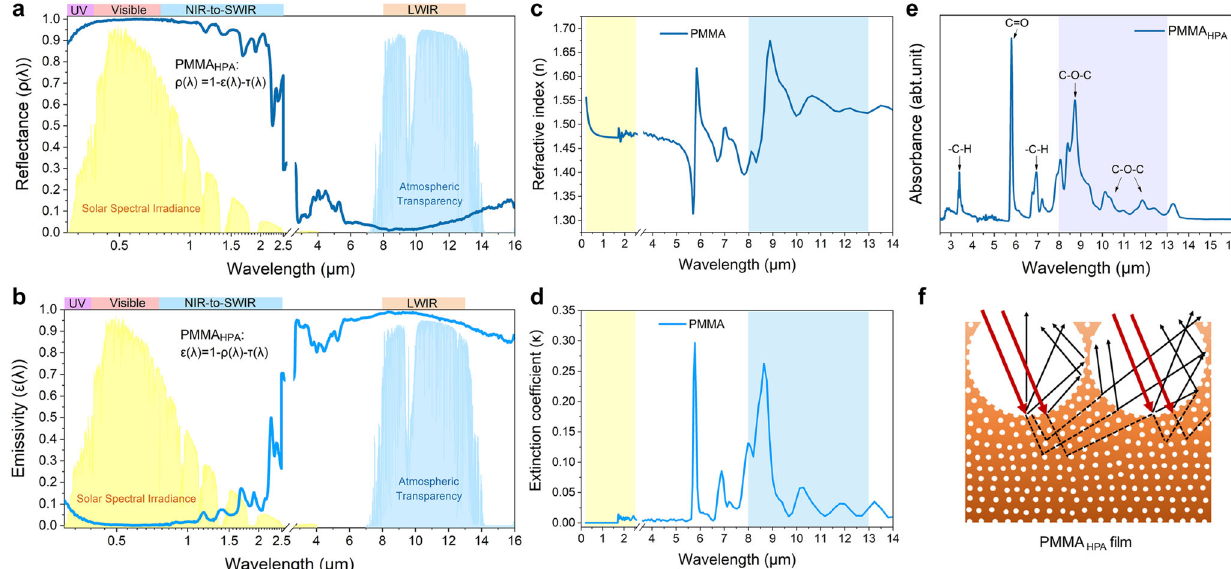
Fig. 2 Spectroscopic response of the PMMA HPA fi lm. a , b Spectral re fl ectance and emissivity of the PMMA HPA fi lm with ~160 μ m effective thickness along with the normalized ASTM G173 Global solar spectrum and the LWIR atmospheric transparency window. c , d Spectral refractive index (n) and extinction coef fi cient ( κ ) of PMMA, showing negligible absorptivity in the solar range and multiple extinction peaks in the LWIR wavelengths. e Absorbance spectrum of PMMA HPA measured with ATR-FTIR spectroscopy. f Schematic diagram showing the periodic re-entrant structure with nano/microscale pores is conducive to enhance the total scattering ef fi ciency by multiple re fl